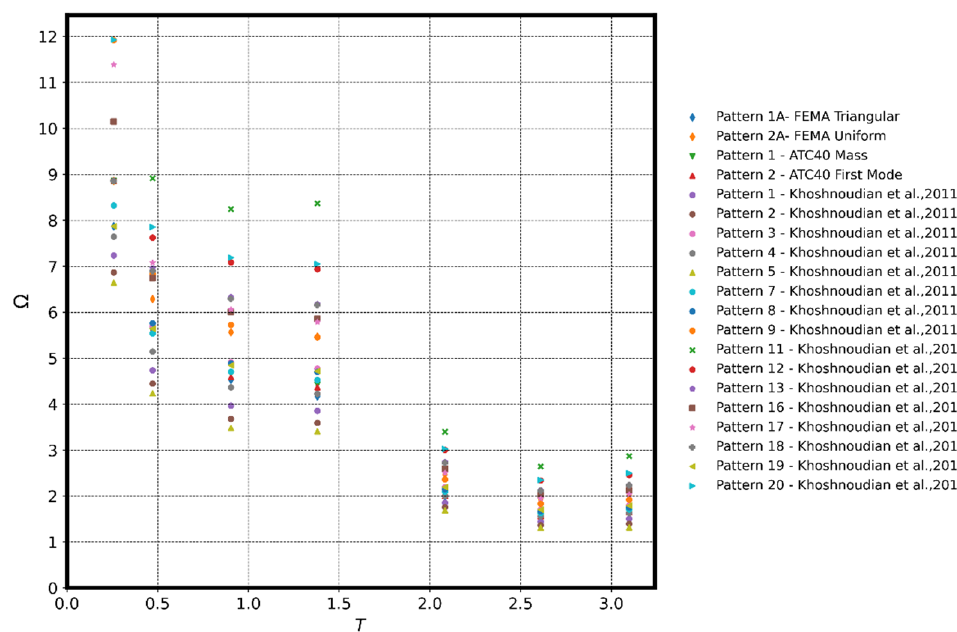
Figure 7. Ductility reduction factor versus period for different patterns.